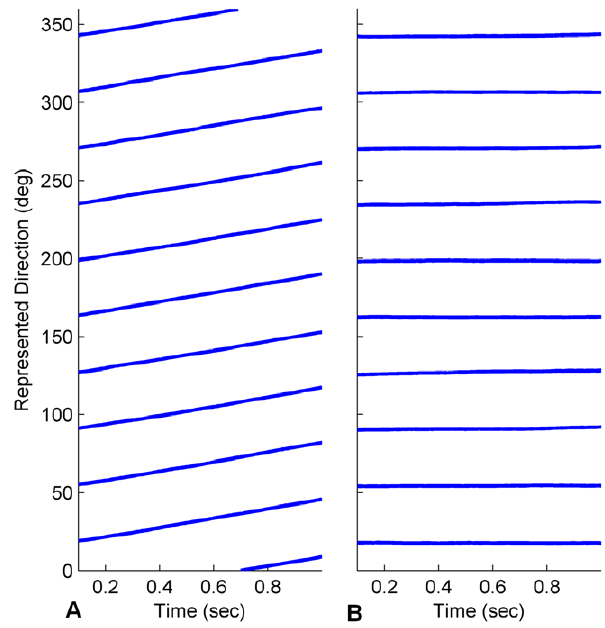
Figure 7. Head direction stability was greatly improved by training. The graphs track the centre of multiple HD bumps started at one of many positions in the HDAAN. (A) Prior to training, a head direction bump initiated at any one of 10 positions around the HDAAN drifted continuously. (B) Following training, drift was eliminated and the bump was stable in all positions.